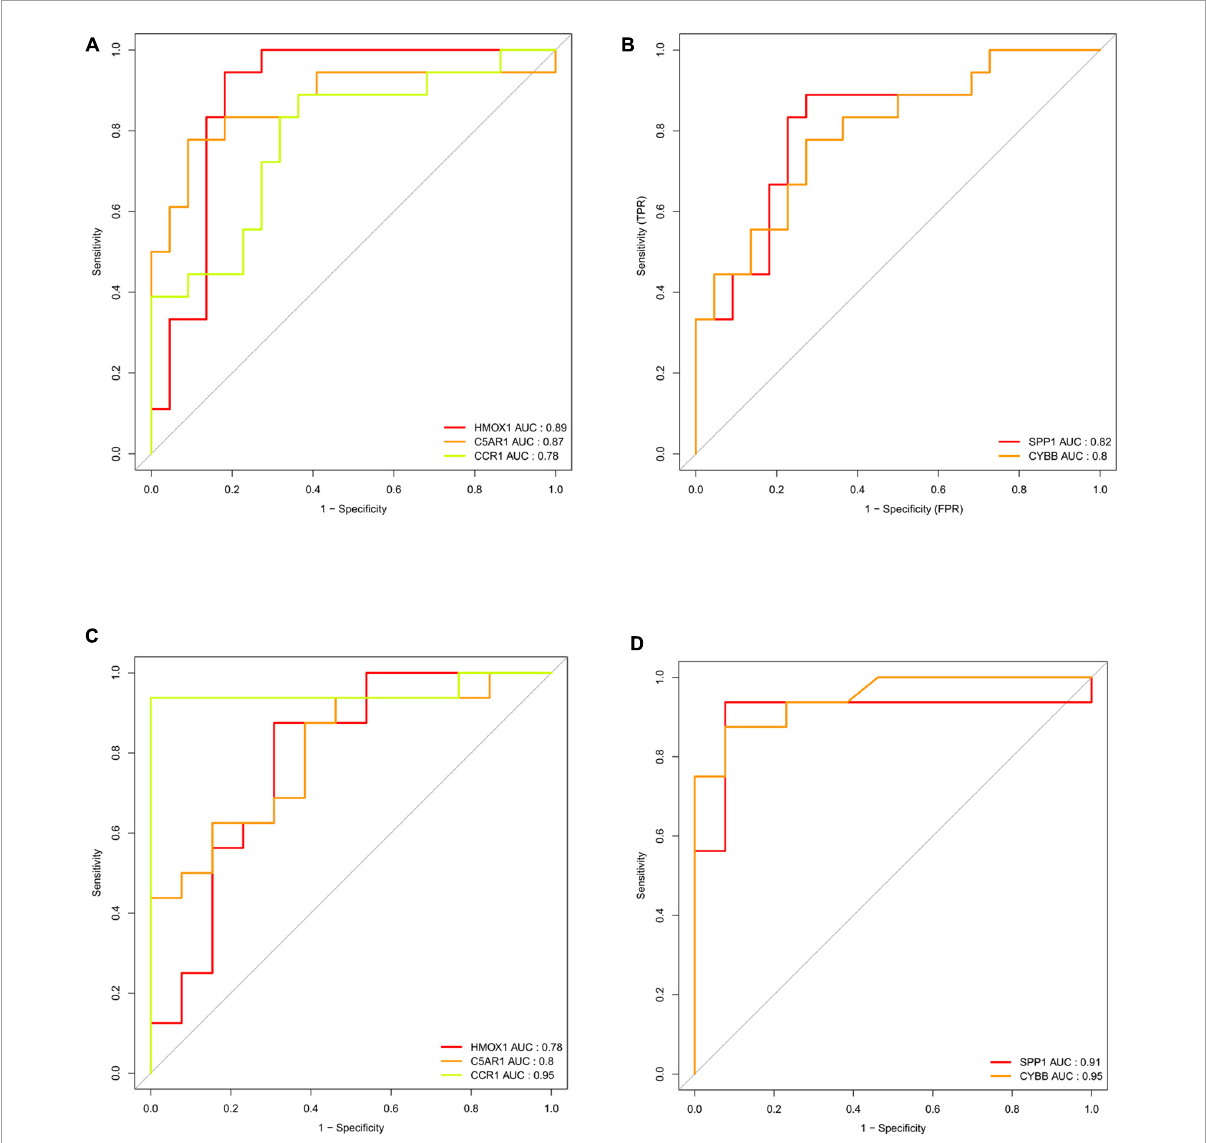
FIGURE10 Validation of key genes (HMOX1, C5AR1, CCR1, SPP1, and CYBB) in the validation datasets. (A) Receiver operating characteristic (ROC) analysis of HMOX1, C5AR1, and CCR1 in the validation dataset of vascular dementia. (B) ROC analysis of SPP1 and CYBB in the validation dataset of vascular dementia. (C) ROC analysis of HMOX1, C5AR1, and CCR1 in the validation dataset of carotid plaque. (D) ROC analysis of SPP1 and CYBB in the validation dataset of carotid